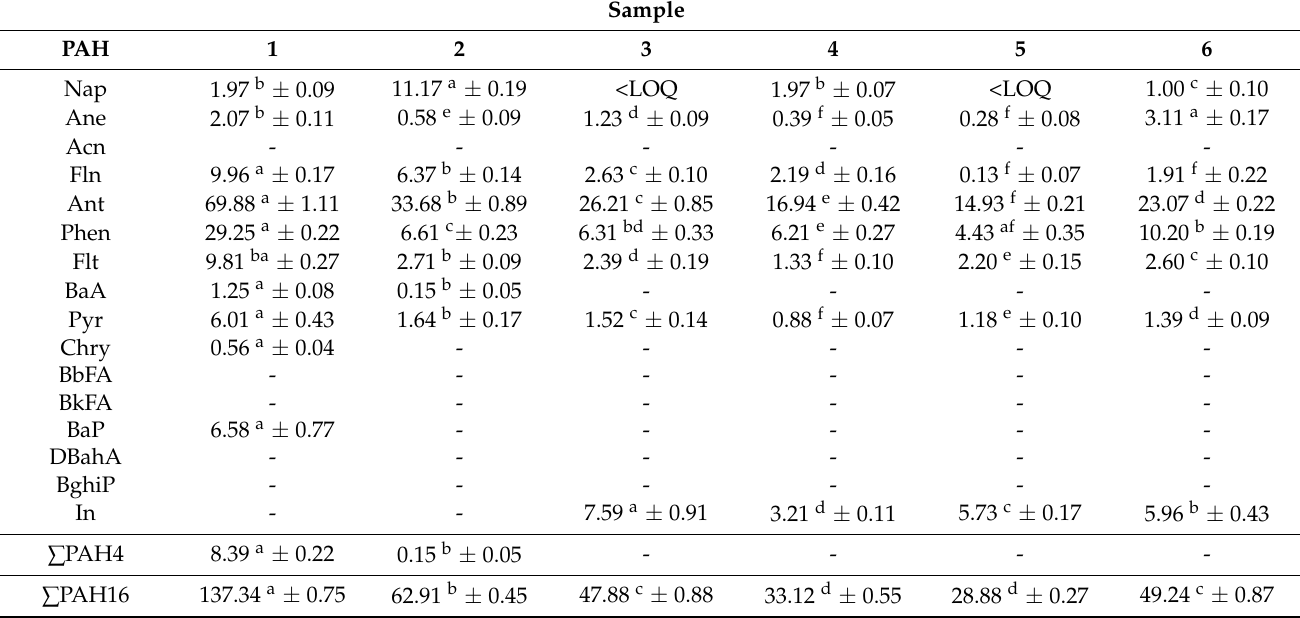
Table 4. PAH content ( µ g/kg) in different popcorn varieties in year